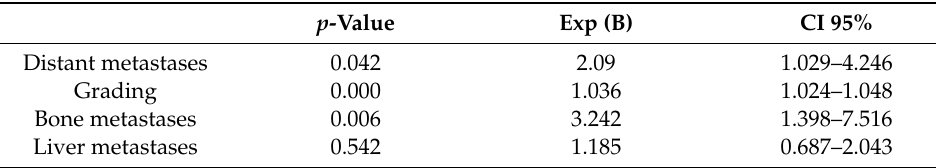
Table 5. Cox proportional hazard regression